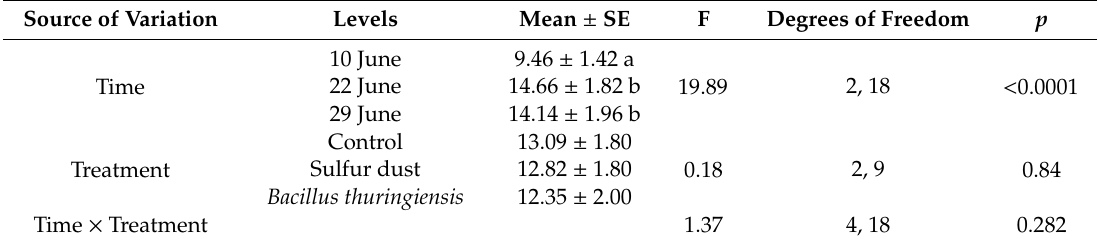
Table 3. Side-e ff ects of sulfur dust on the phytoseiid mite Kampimodromus aberrans. Motile forms per leaf recorded on three dates in 2018. On 10 June, sampling was undertaken just before the application of sulfur dust and B. thuringiensis and on 22 June, just before the second application of the bio-insecticide. Source of Variation